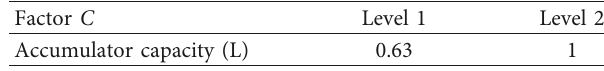
Table 3: Hydraulic accumulator specification.